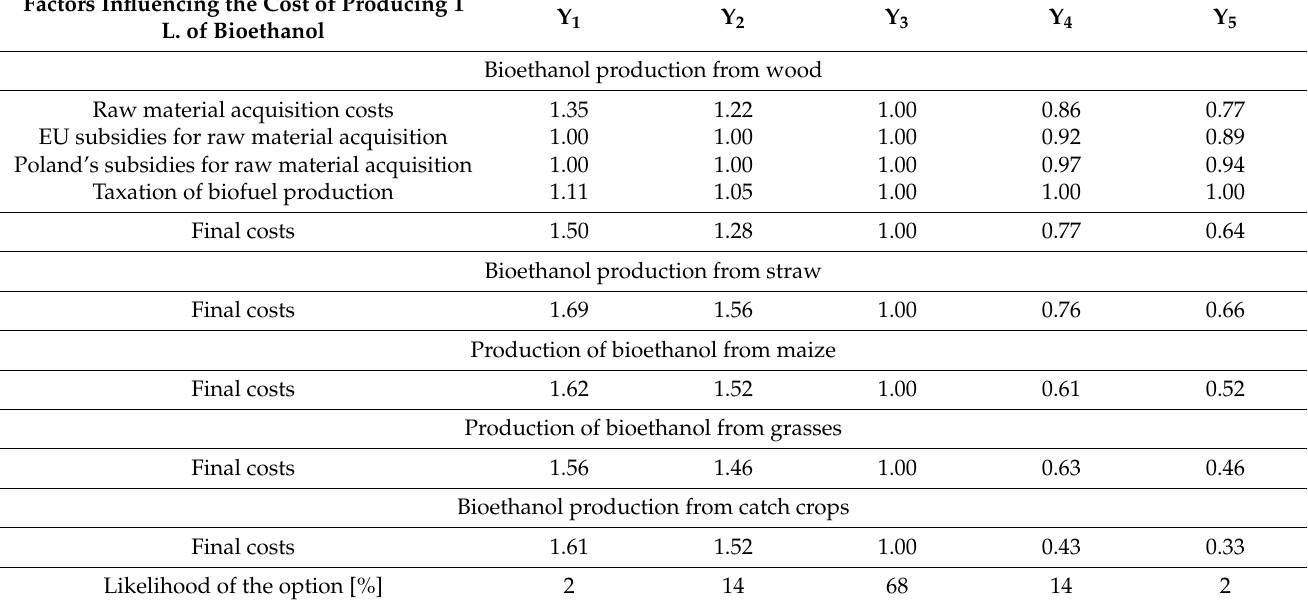
Table 4. Production strategies of second-generation bioethanol from selected raw materials in Poland in diversified cases of the economic and social environment. The possible situations related to the production of second-generation biofuels are presented with the likelihood of the occurrence of a relevant condition in the economic and social environment [%]. For the production of second- generation bioethanol from raw material with the highest significance in the expert mathematical method (wood), all of the important production costs are presented in detail for the individual components determining the size of these costs and the index of increase or decrease for the final costs. For the remaining raw material cases, only the final cost index of this production is presented in this table for